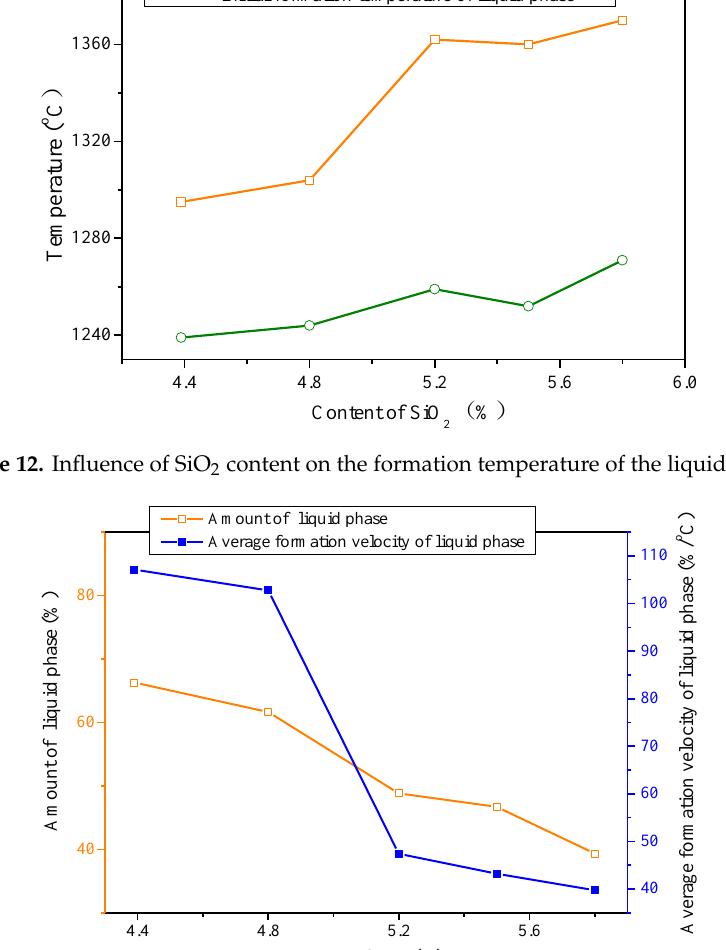
Figure 14. Relationship between the structures of SFCA and the liquid formation temperatures of SFCA.